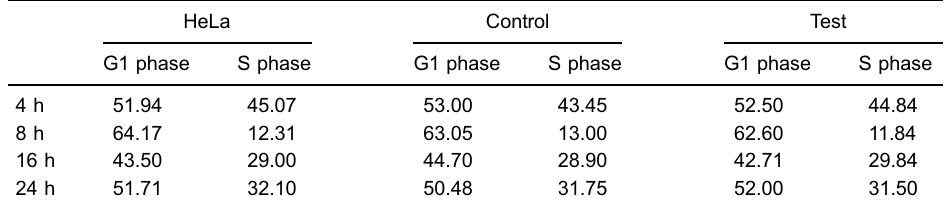
Table 3. Proportion of cells in G1 and S phases after incubation with phosphate-buffered saline for different times.